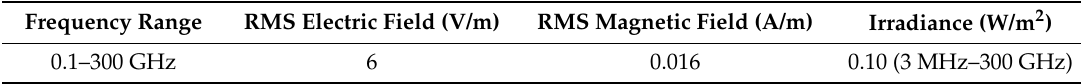
Figure 2. Electromagnetic field measurement set-up. ( a ) Measurement points; ( b ) measurement probe. Table 1. Limits of human exposure to electromagnetic fields [18].